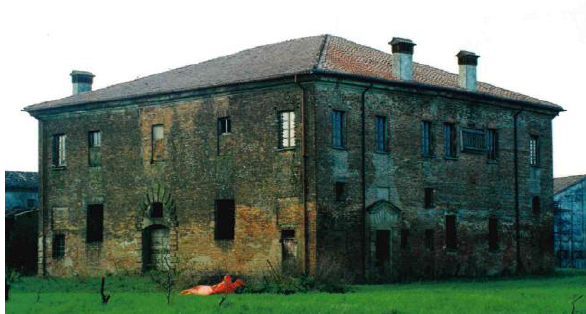
Figure 1: Villa Galvagnina in the 1990’s (Private archive of Federico